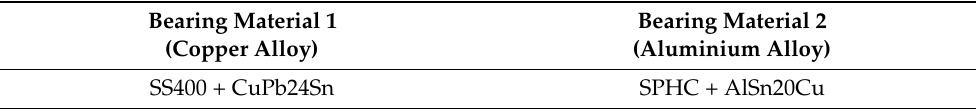
Table 1. Frictional accessory